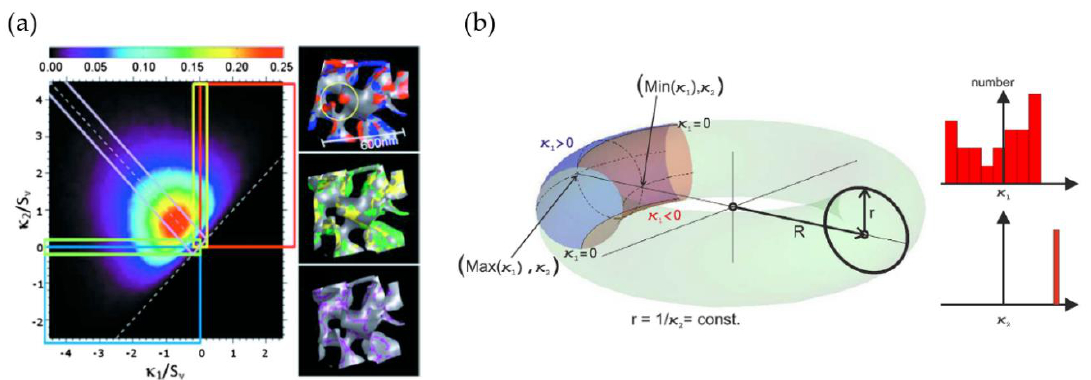
Figure 5. ( a ) Interfacial shape distribution (ISD) plot with near zero average mean curvature, and highlighted surface patches of convex (red) and concave (blue) regions, transition regions (yellow, green), zero mean curvature regions (purple) by Chen et al. [17]; ( b ) schematic ring with inscribed curvature parameters κ 1 and κ 2 by Ziehmer et al. [42]. Reprinted from [17] with the permission of AIP Publishing and [42] with permission from Elsevier.